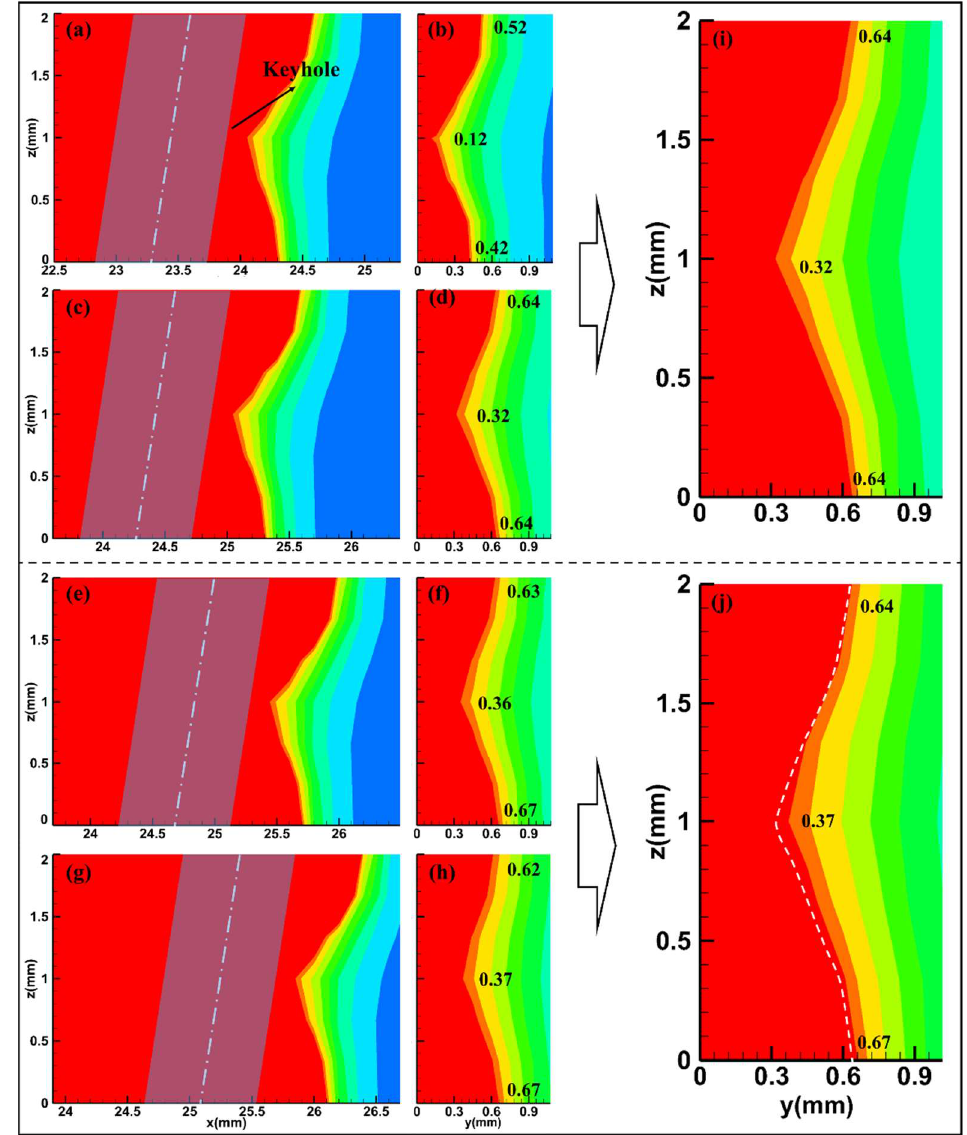
Figure 6. Longitudinal sections and cross sections obtained from the transient temperature field ( a , b ) at 0.429 s, ( c , d ) at 0.447 s, ( e , f ) at 0.455 s and ( g , h ) at 0.462 s. And WCSs obtained from the maximal temperature field at ( i ) 0.447 s and ( j ) 0.462 s.